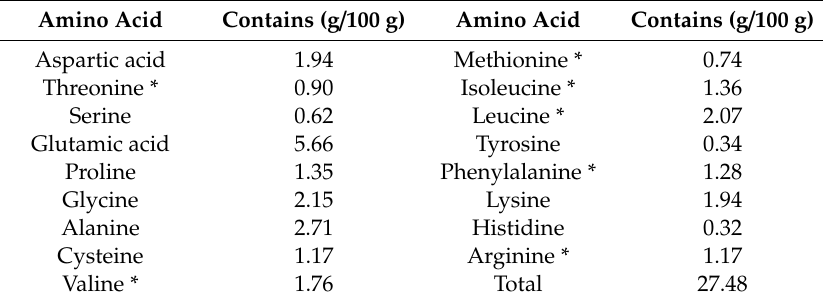
Table 2. Main peptide sequences analysis from of SMPs.